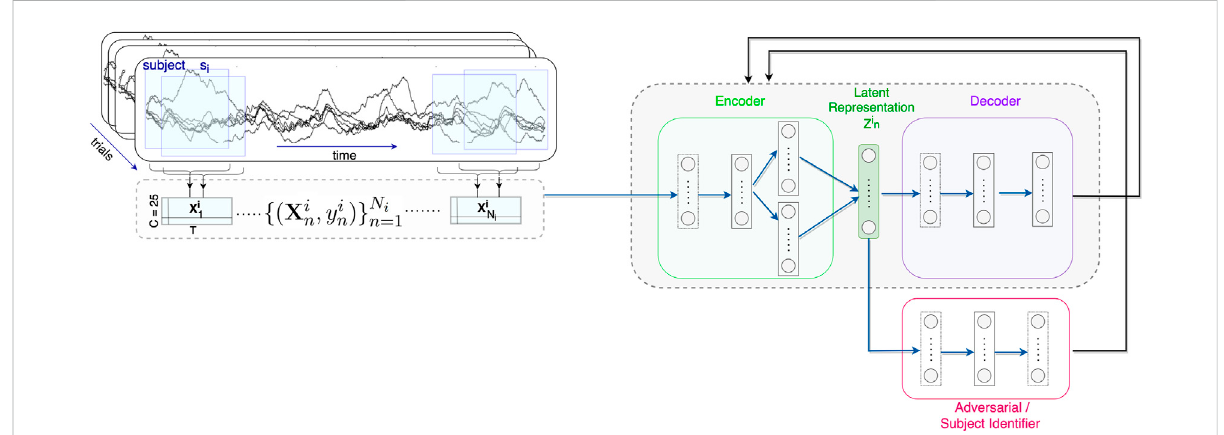
FIGURE 1 Schematic representation of the proposed model architecture for mTBI subject-invariant feature extraction. Cortical activity from C =25 channels are collected. For each subject s i , a sliding window with the duration of T and step size of w time points is used, and the sampled data matrices {( X i n , y i n )} are collected. The y i n ∈ { 0 , 1 } represents the mTBI or normal class label. The autoencoder maps the data X i n to the latent representation z i n . The adversarial network is trained to minimize the subject dependency in the